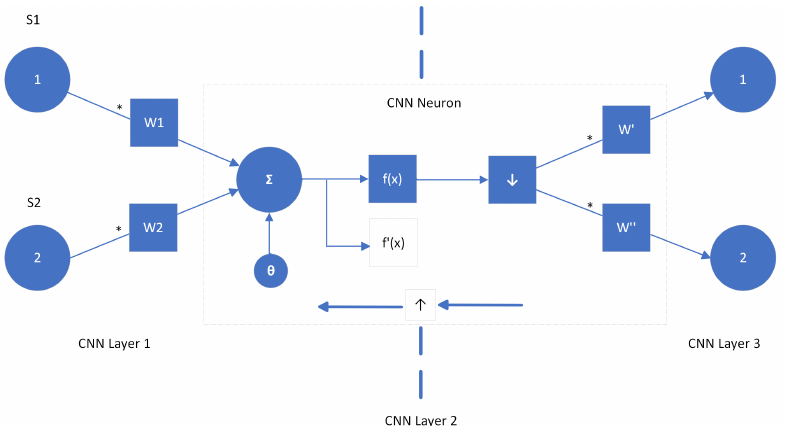
Figure 2. The hidden 1D-CNN layers: S 1 , S 2 and w 1 , w 2 are the outputs and kernels of the previous neurons of layer 1 (one), respectively (* means